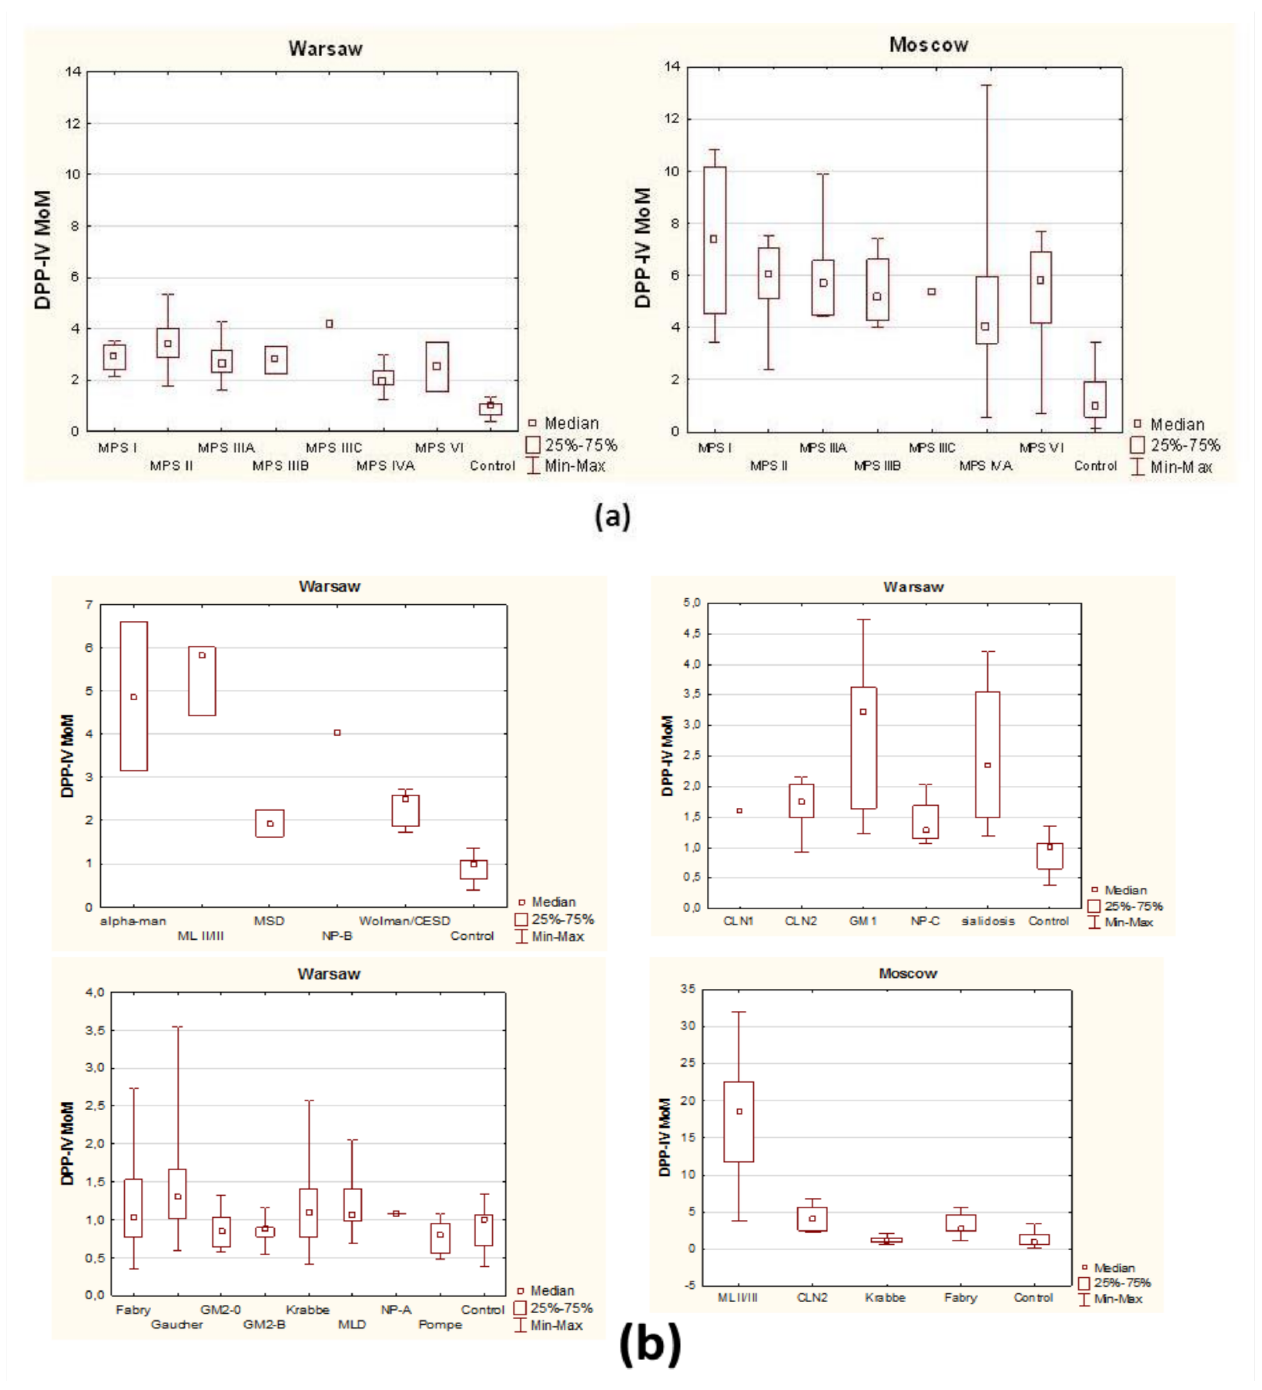
Figure 1. Dipeptidyl peptidase IV (DPP-IV) activity MoM (Multiple of the Median): ( a ) In patients with mucopolysacchari- doses (Warsaw and Moscow Labs); ( b ) in patients with other than mucopolysaccharidoses lysosomal diseases (Warsaw and Moscow